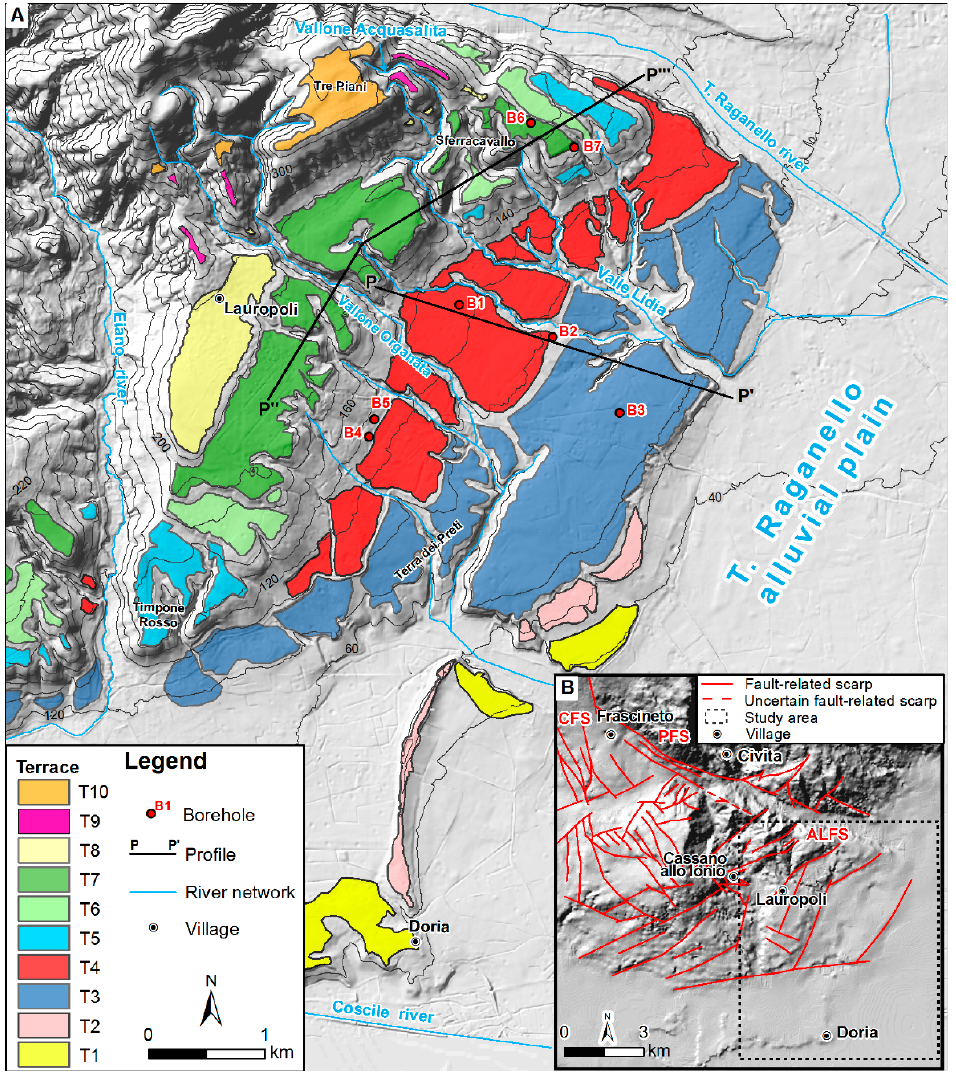
Figure 2. ( A ) Morphological map of the Middle–Late Pleistocene terraces between the Eiano and T. Raganello river valleys. Noteworthy are cross-cut relationships among terraces, well apparent on the right side of the T. Raganello. ( B ) Morphostructural map (modified after [5,27]); of the Ionian coast of northern Calabria. CFS: Castrovillari Fault System; PFS: Pollino Fault System; ALFS: Avena–Lauropoli Fault System.